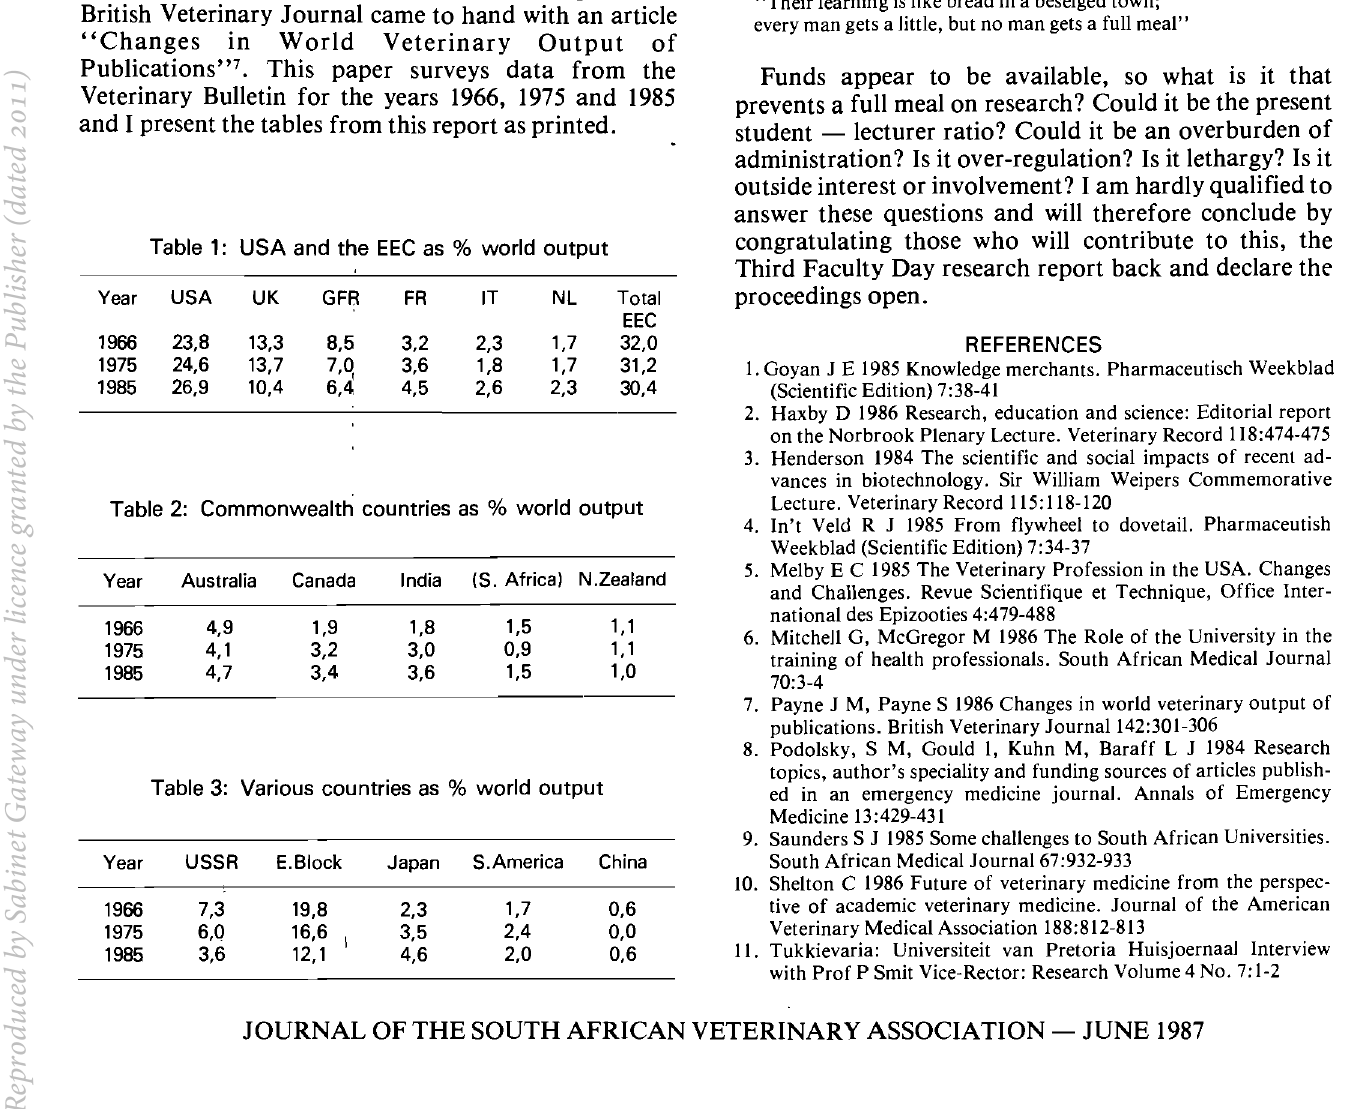
Table 3: Various countries as % world output